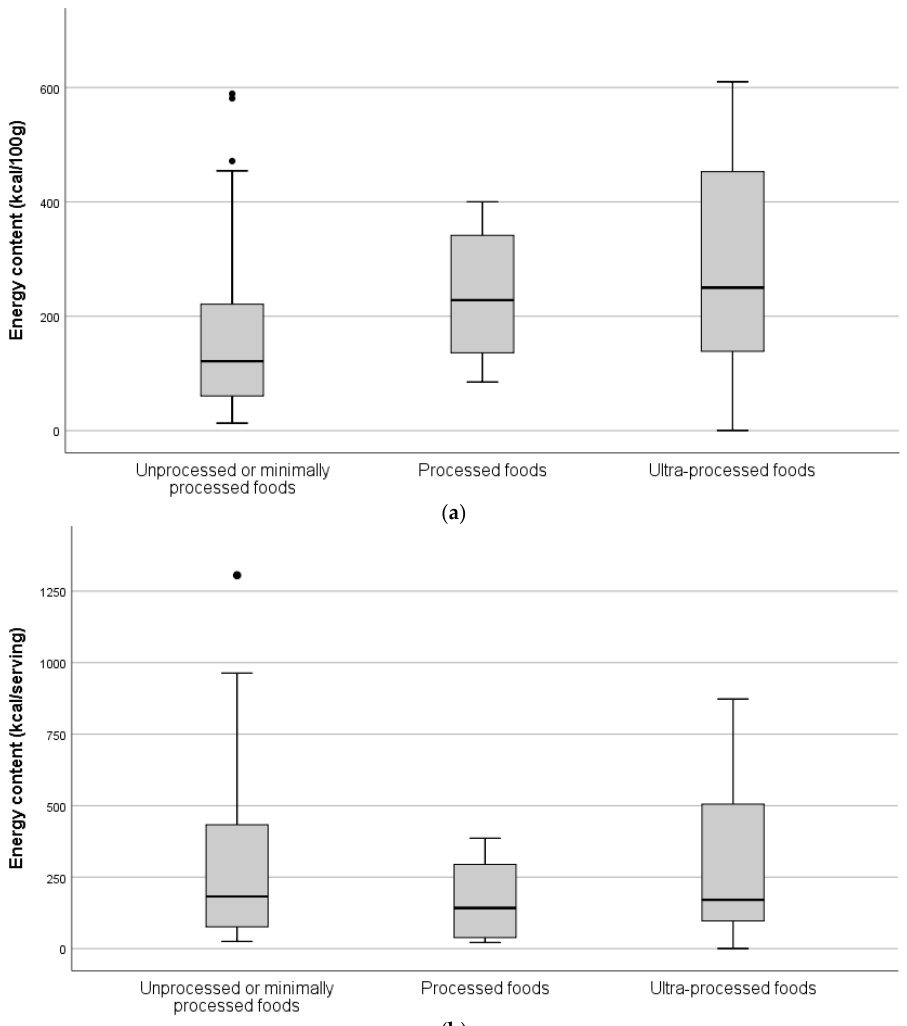
Figure 1. Estimated energy content per 100 g ( a ) and per serving ( b ) of the unprocessed/minimally processed, processed, and ultra-processed foods available ( n = 810, vending sites available for interview).